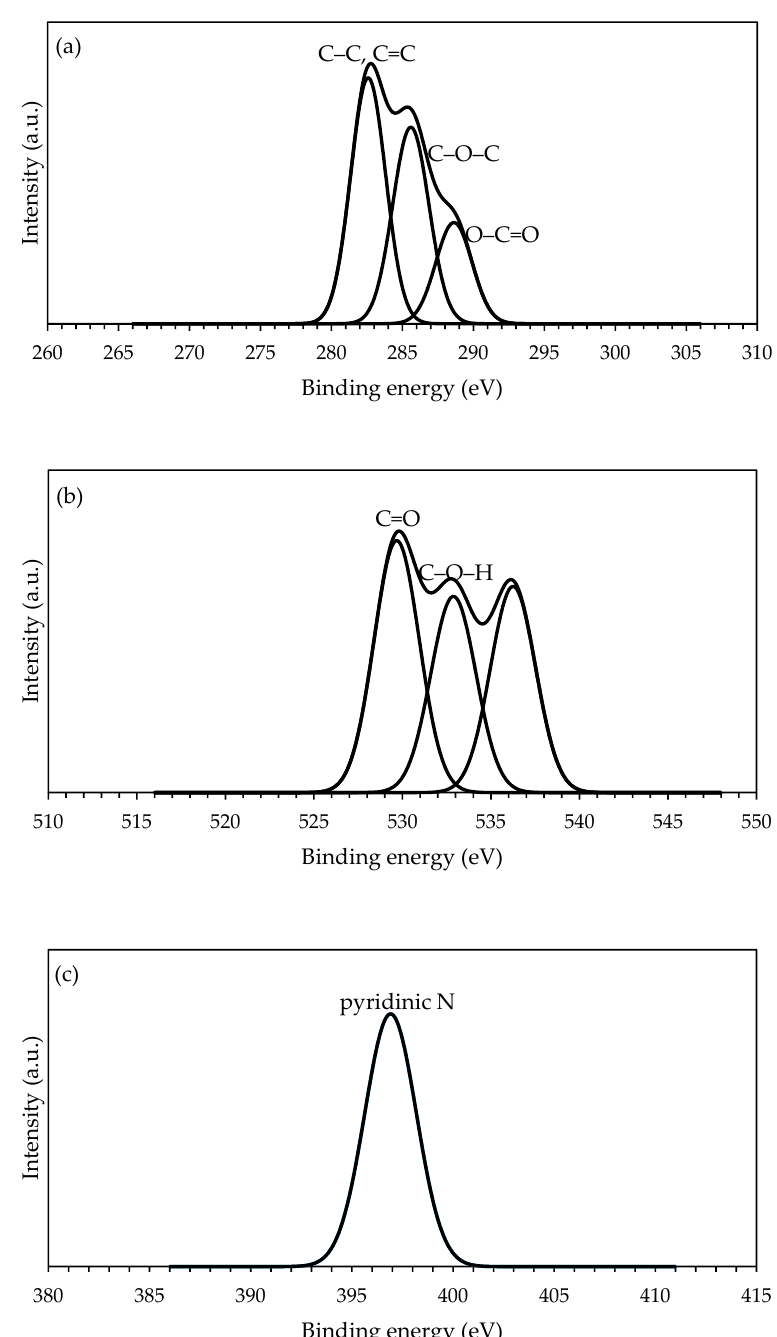
Figure 8. ( a ) C 1s , ( b ) O 1s , and ( c ) N 1s spectra of PAN/SL ACNFs.